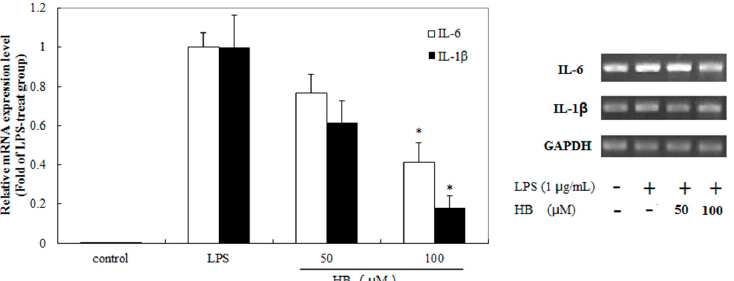
Figure 7. Effect of HB on LPS-induced expression of IL-6 and IL-1 β in RAW 264.7 cells. RAW 264.7 cells were pretreated with 50 and 100 µ M HB for 1 h before treatment with 1 µ g/mL LPS. After incubation for 18 h, the expression of levels of IL-6 and IL-1 β mRNA were measured by RT-PCR analysis. The data is expressed as mean folds of the mRNA expression versus LPS-stimulated group. The values are presented as means ± SD of three independent experiments. * p < 0.05, compared to the LPS-treated group.